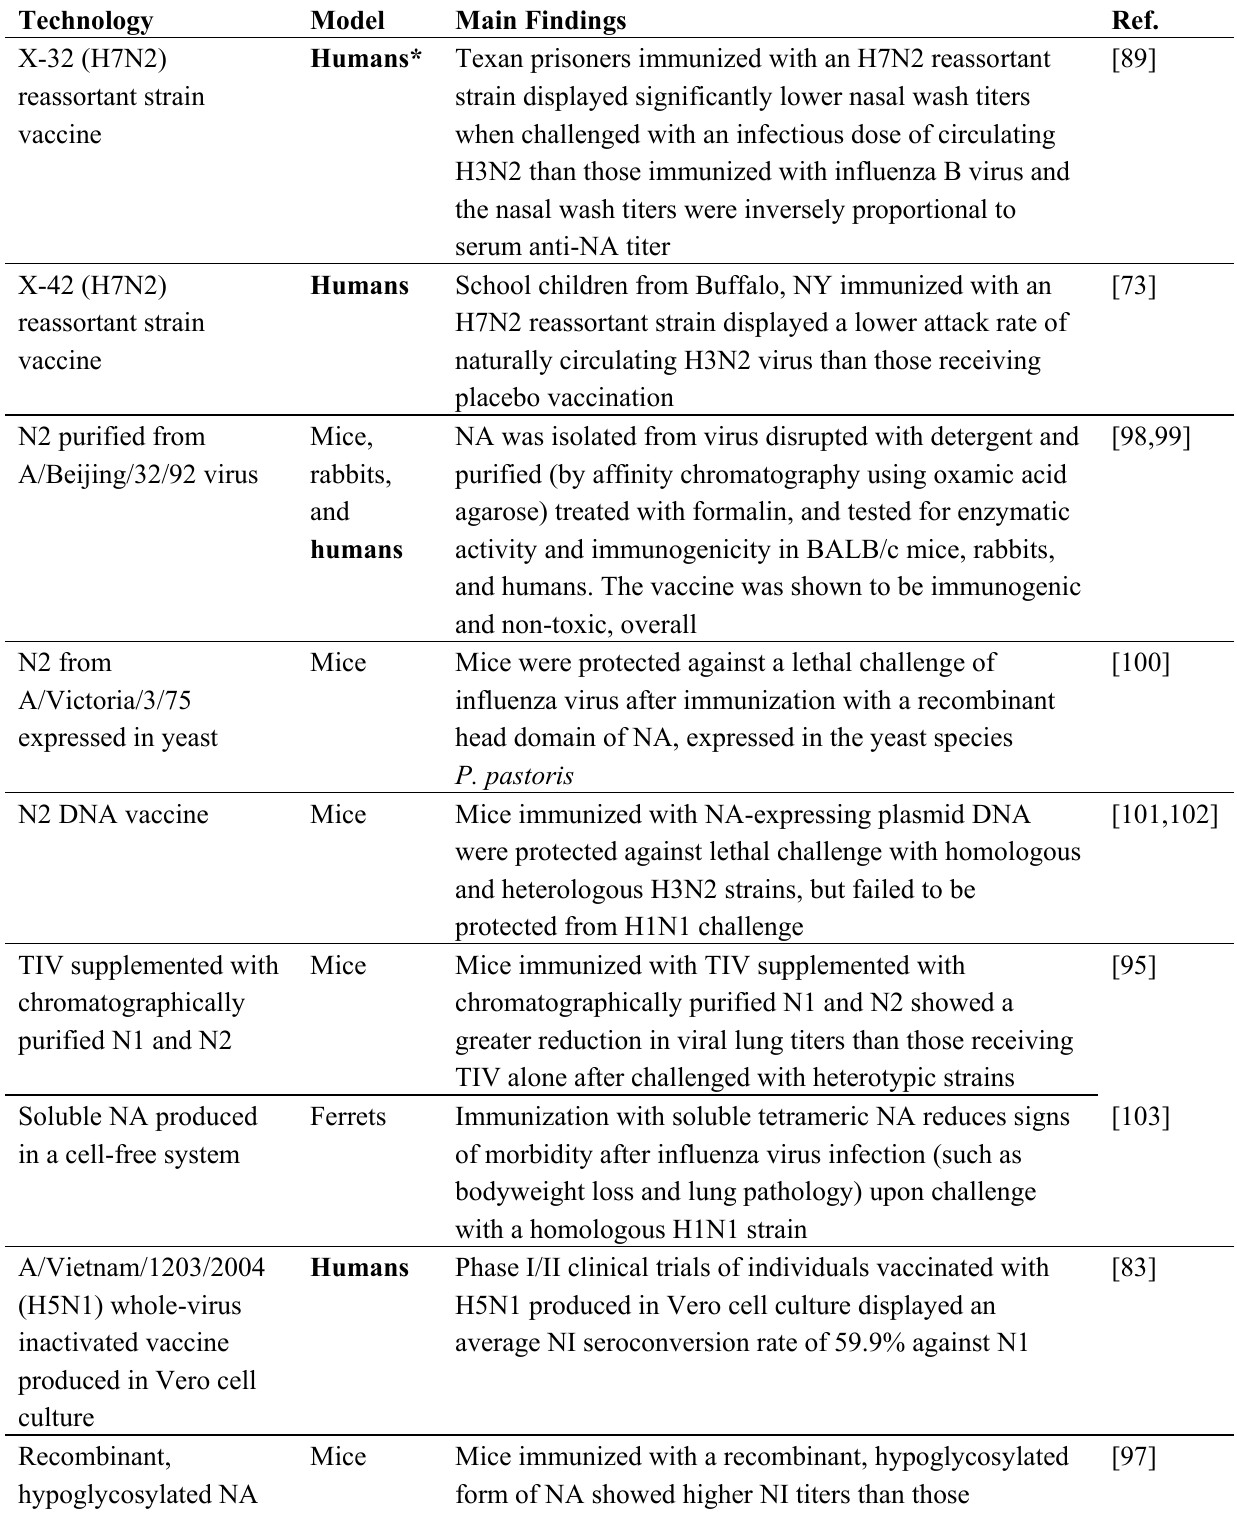
Table 1. NA-based vaccination